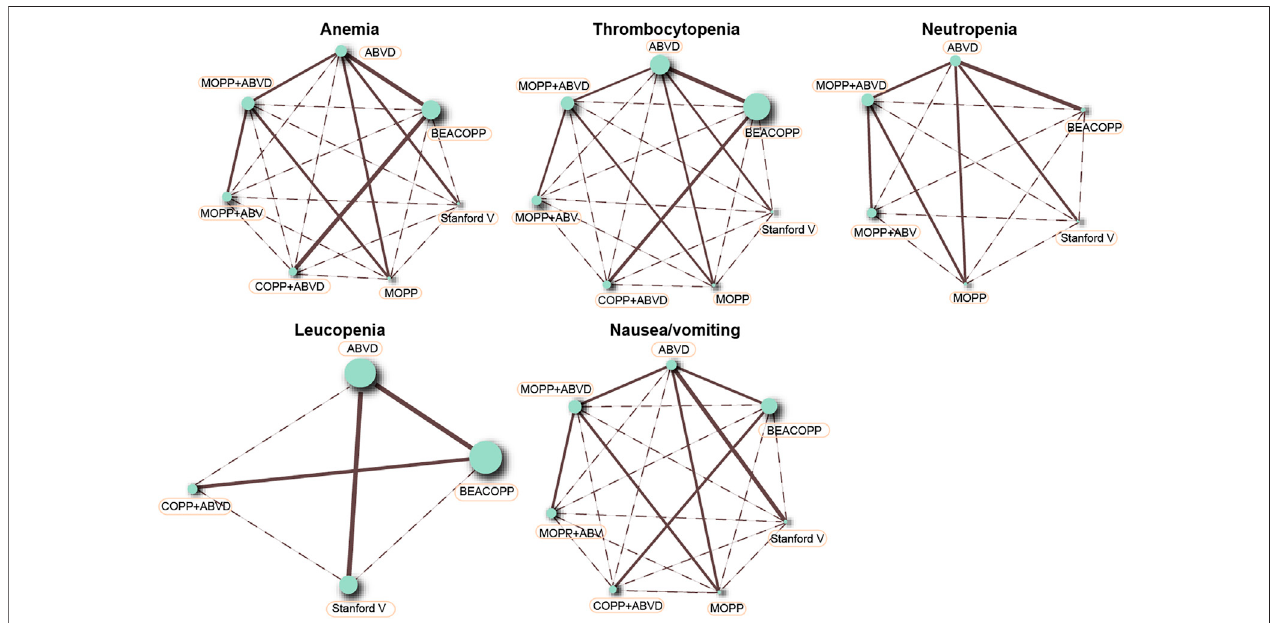
FIGURE 3 | Anemia, thrombocytopenia, neutropenia, leucopenia, and nausea/vomiting in advanced HL patients treated with different chemotherapy regimens.